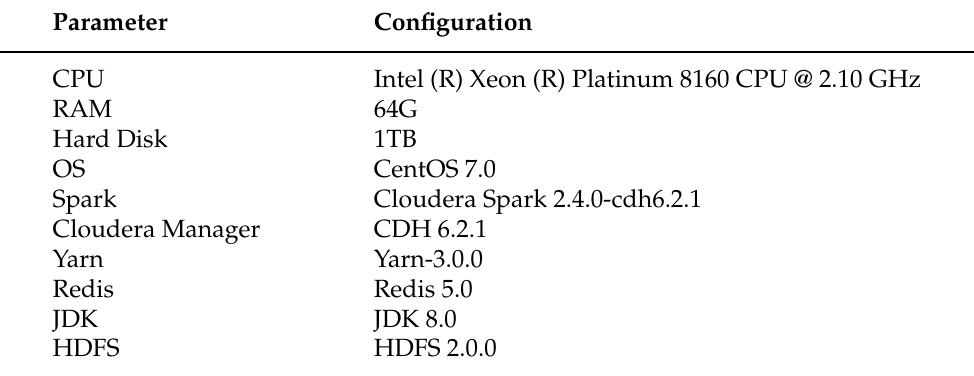
Table 1. Resource configuration information.